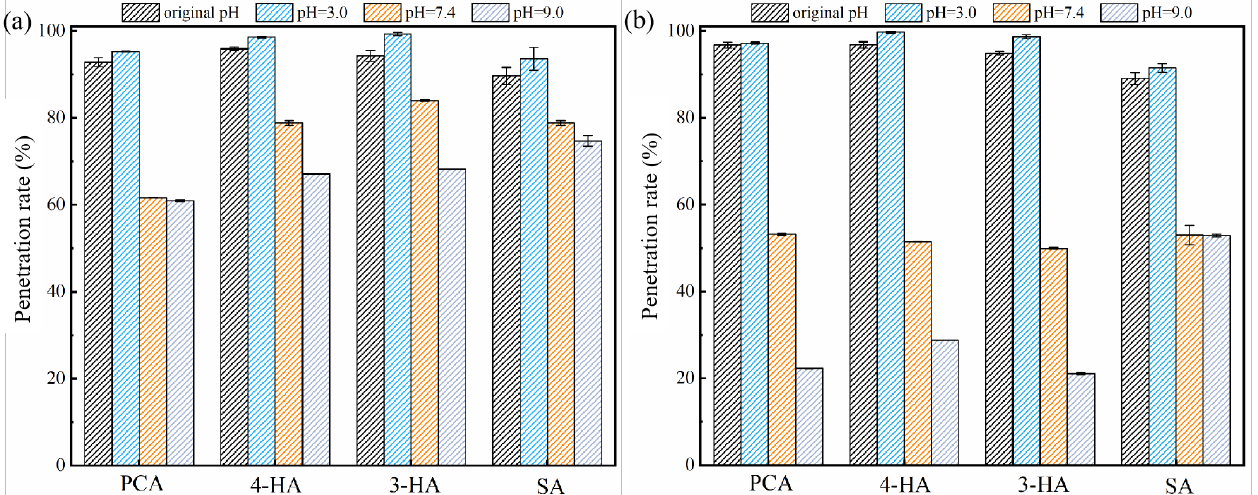
Figure 10. The dissociation percentages of the five phenolic acids at different pH (( a ), for pH = 3.0; ( b ), for pH = 7.4; ( c ), for pH = 9.0). feed concentration = 1 mM. Table 3. The properties of phenolic acids at different pH (feed concentration = 1 mM.).